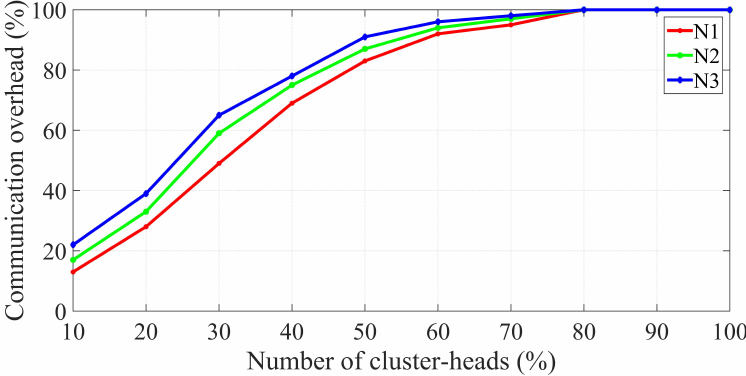
Figure 4. Percentage of the communication overhead with the change in the number of cluster heads, for different values of number of deployed vehicles.